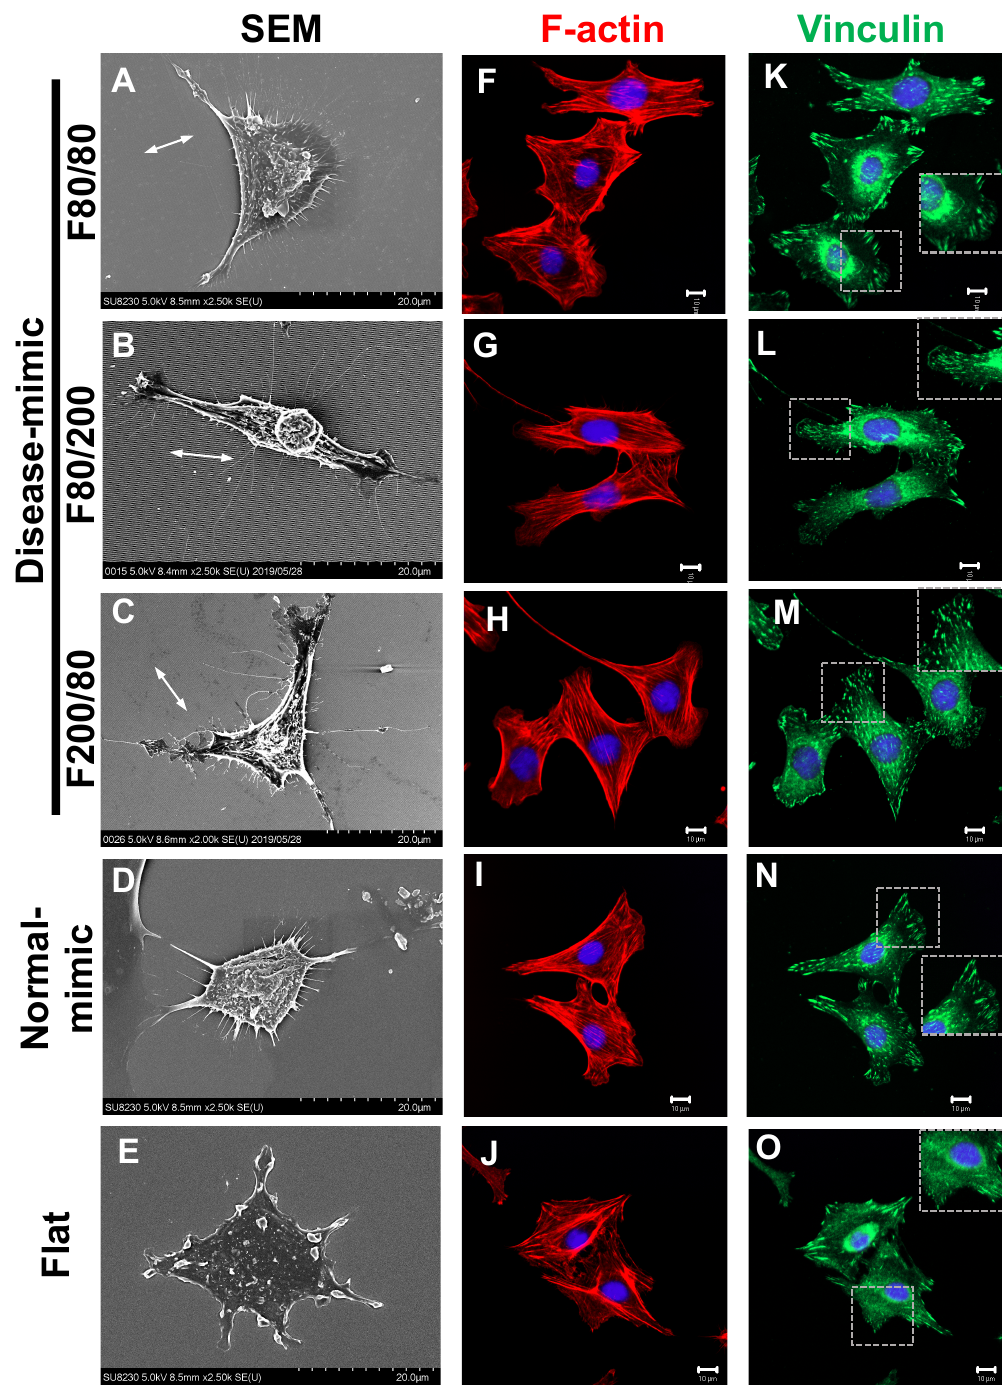
Figure 4. MES13 cell morphological and cytoskeletal changes in disease- and normal-mimic nanopatterns. Cells were adhered to various TiO 2 nanopatterns for 24 h, and cellular morphology was observed by SEM micrographs ( A–E ). Confocal microscopy images show the actin cytoskeleton ( F–J , red), the cytoskeletal protein vinculin ( K–O , green) and nuclei (blue) in cells after culturing on TiO 2 nanopatterns for 24 h. The inlay highlights the focal adhesion spots. Scale bar = 20 µ m ( A–E ) or 10 µ m ( F–O ). The white arrow indicates the direction of the